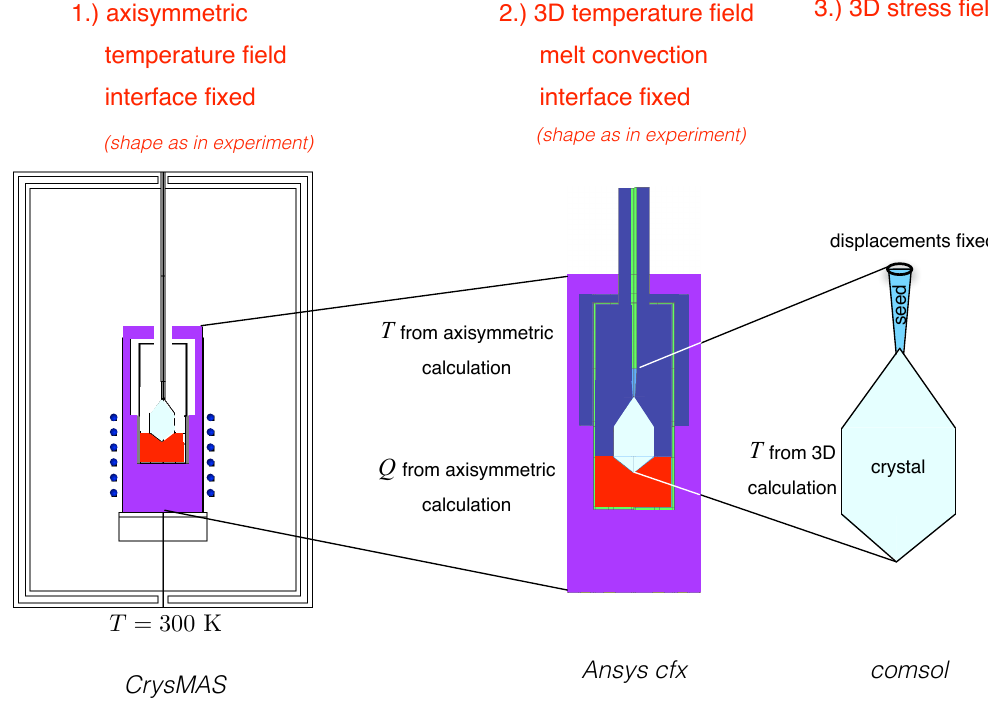
Figure 2. Sketch of the geometry and the computational steps. Below: the software